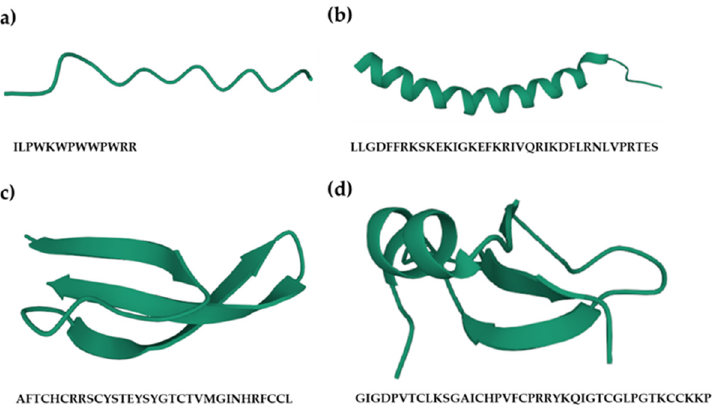
Figure 1. Structures of antimicrobial peptides (AMPs). Based on their structures, AMPs can be divided into four categories, including ( a ) linear peptide, e.g., bovine antimicrobial peptide indolicidin (protein databank, PDB: 1G8C); ( b ) α -helical peptide, e.g., human host defense cathelicidin LL-37 (PDB: 2K6O); ( c ) β -sheeted peptide, e.g., human α -defensin-6 (PDB: 1ZMQ); ( d ) peptide including both α -helix and β -sheet, e.g., human β -defensin-2 (PDB: 1fd3). All the figures were created using an online 3D view (https://www.rcsb.org/3d-view, accessed on 1 December 2021).